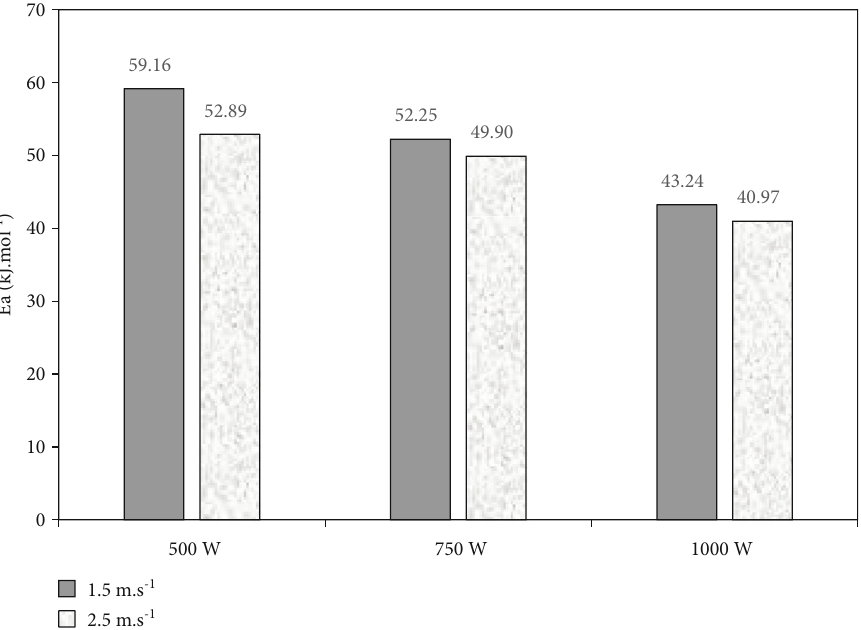
Figure 5: Activation energy of marinated beef under di ff erent IRHAD experimental conditions. Table 6: The average R 2 and RMSE for the thin-layer models at di ff erent IR power levels.